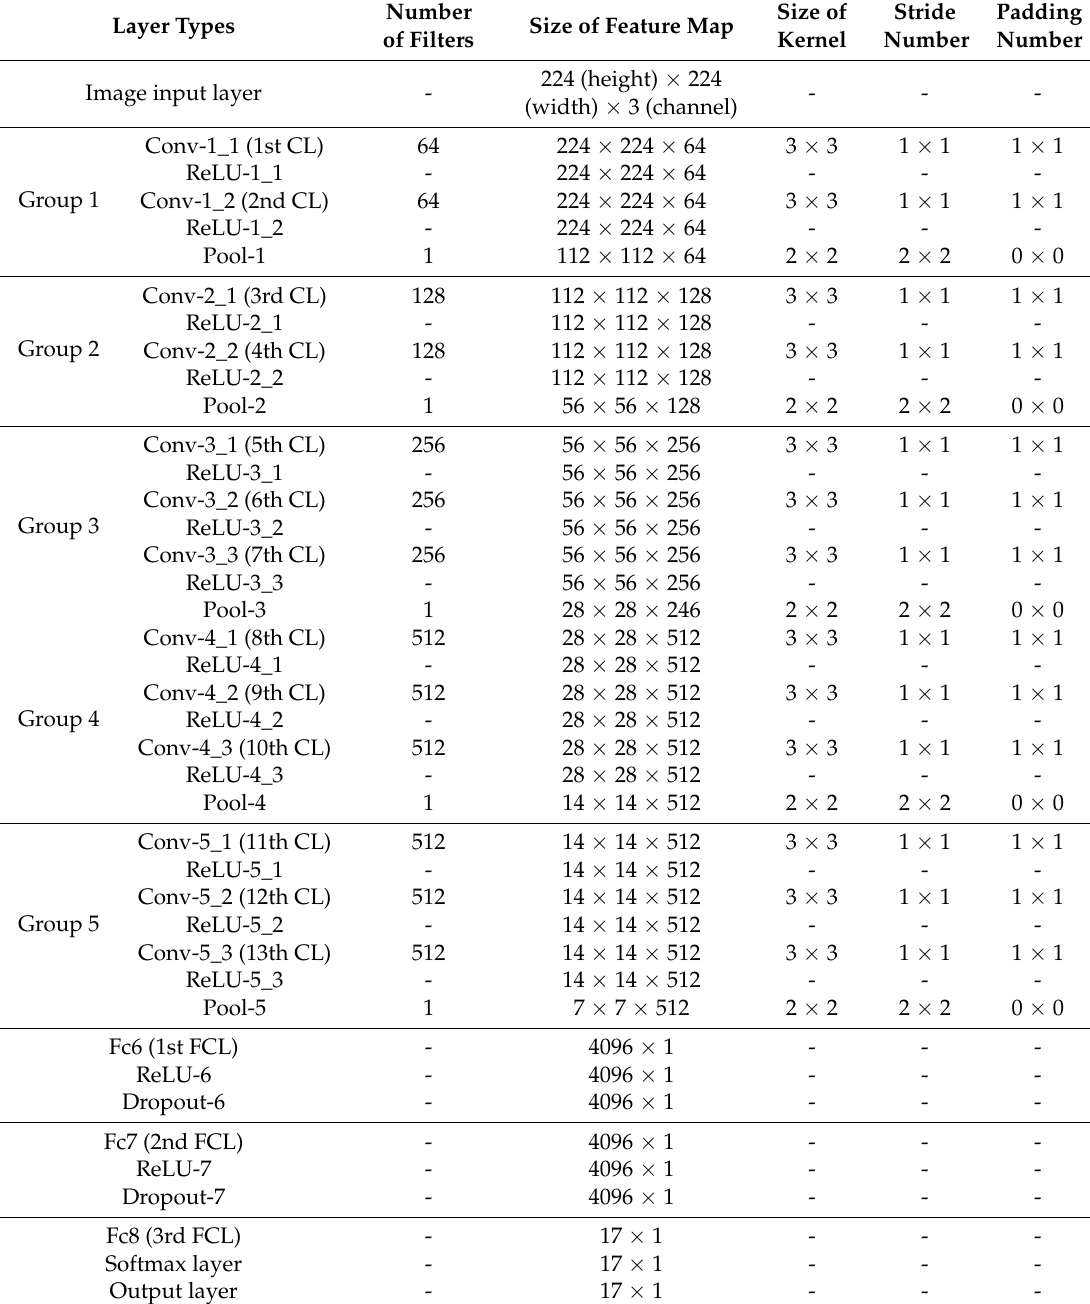
Table 3. Configuration of CNN model used in our research (CL means convolutional